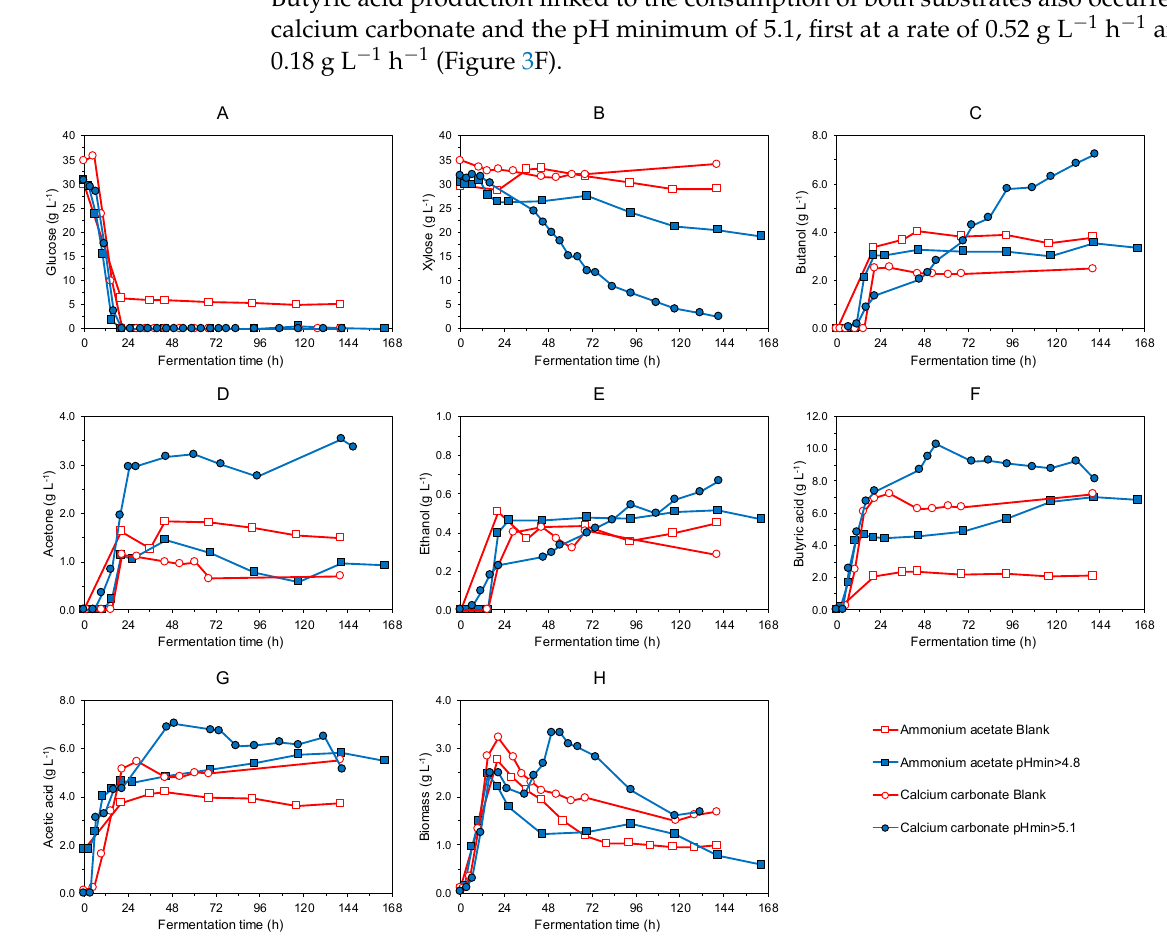
Figure 3. Fermentation profiles of ( A ) glucose, ( B ) xylose ( C ) butanol, ( D ) acetone, ( E ) ethanol, ( F ) butyric acid, ( G ) acetic acid and ( H ) biomass in g L − 1 with C. acetobutylicum with 1:1 ratio of glucose/xylose in batch mode.